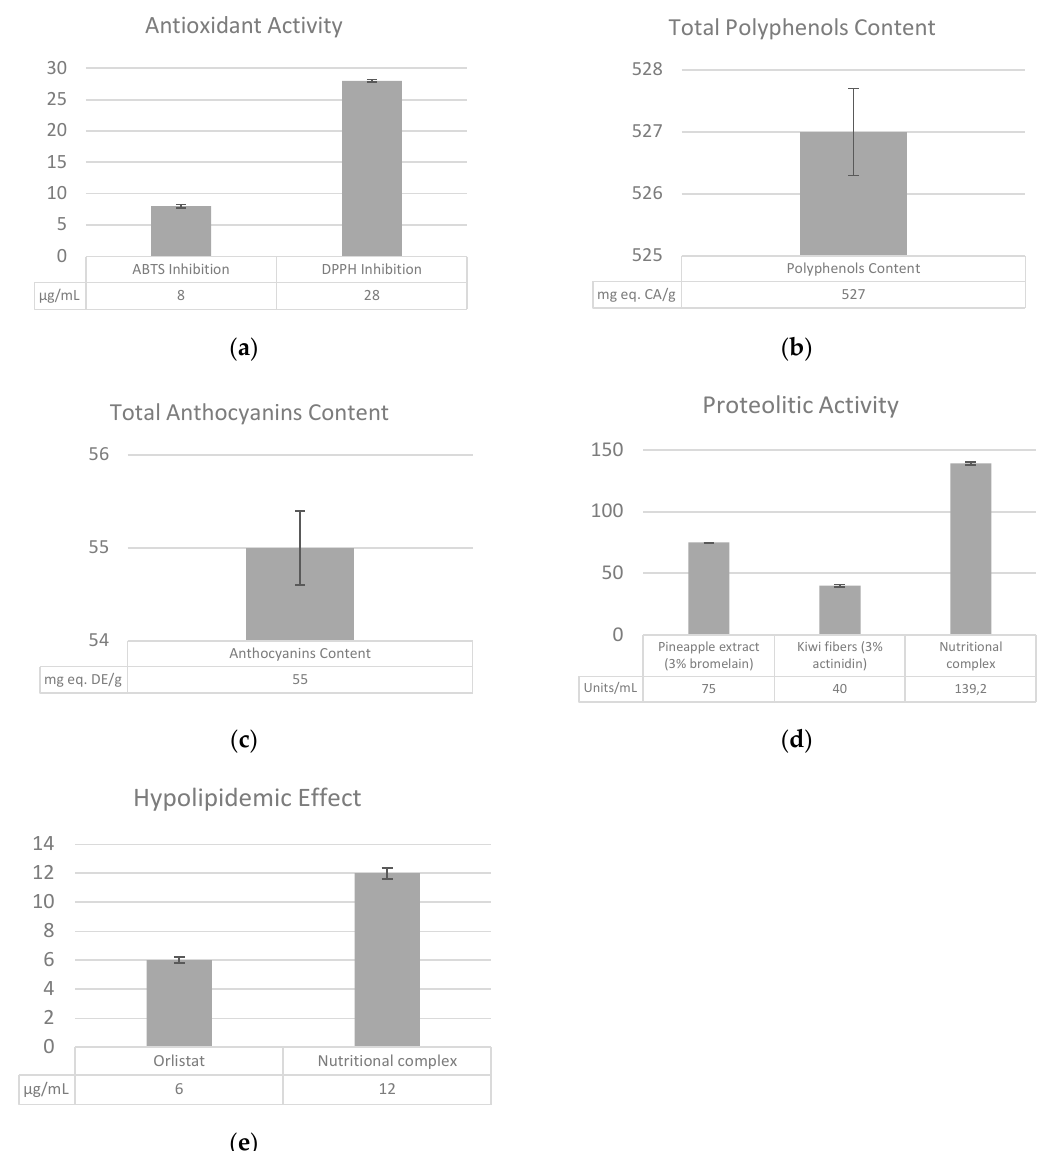
Figure 1. ( a ) Antioxidant activity: Results are expressed for both the ABTS and DPPH assay as the concentration providing 50% of the radical inhibition. ( b ) Total polyphenols content: Data are expressed as milligram of catechin equivalent per gram of sample (mg eq. CA/g). ( c ) Total anthocyanins content: Data are expressed as milligram of delphinidin equivalent per gram of sample (mg eq. DE/g). ( d ) Proteolytic activity: The results are expressed in units/mL. ( e ) Hypolipidemic effect-Pancreatic lipase inhibition. Data are expressed as μ g/mL. Each measurement was carried out in triplicate. Data are expressed as means ± SEM.